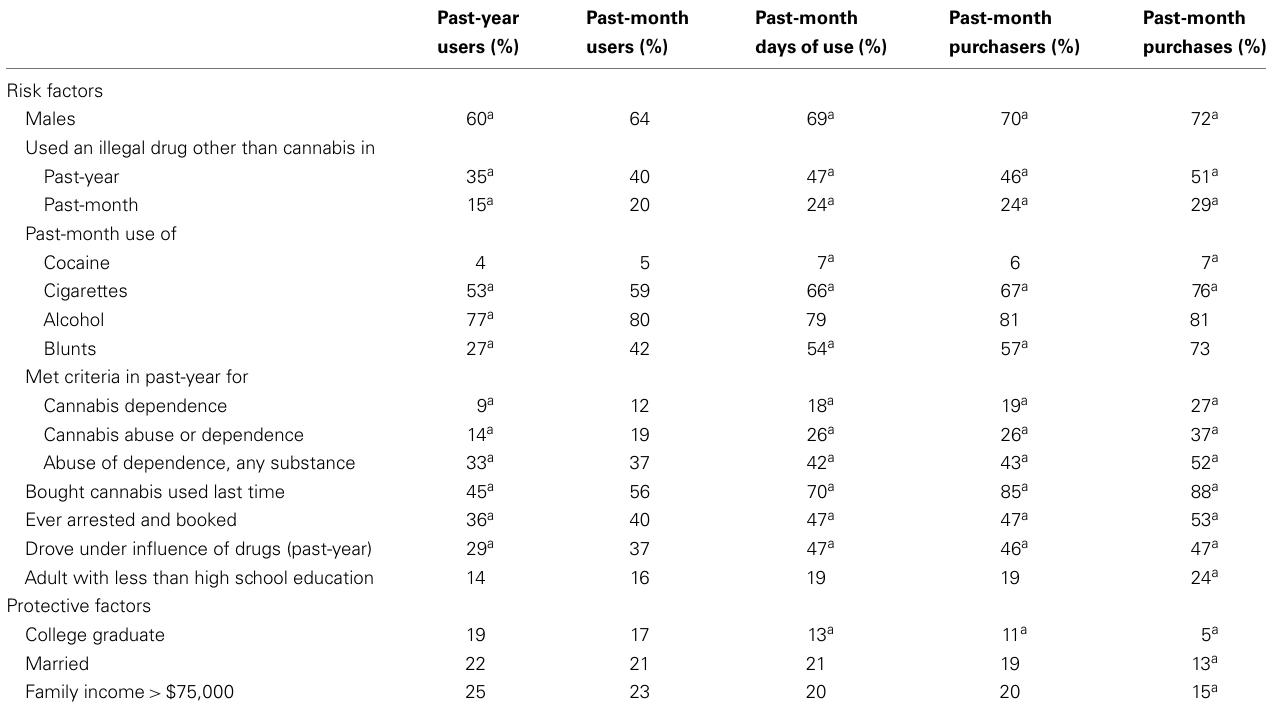
Table 1 |Various populations’ shares of cannabis-related activity by five different measures of participation, 2011